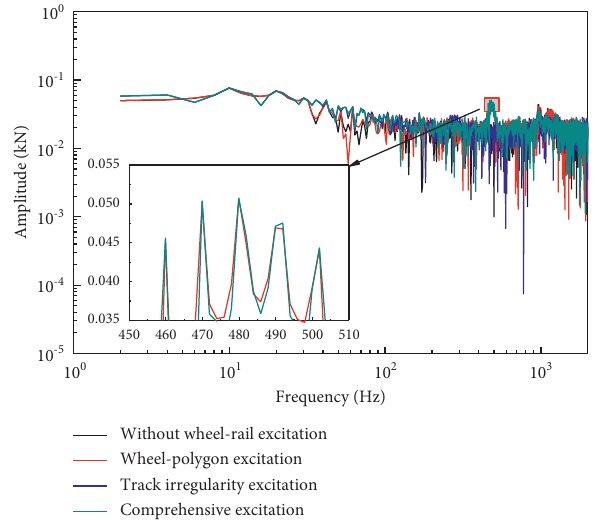
Figure 19: Contact load spectrum.